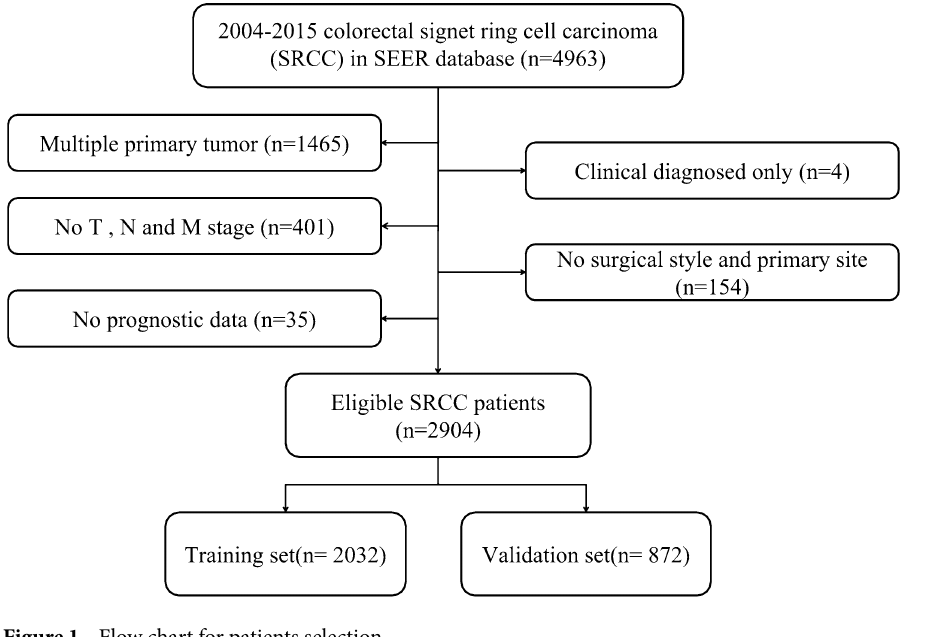
Figure 1. Flow chart for patients